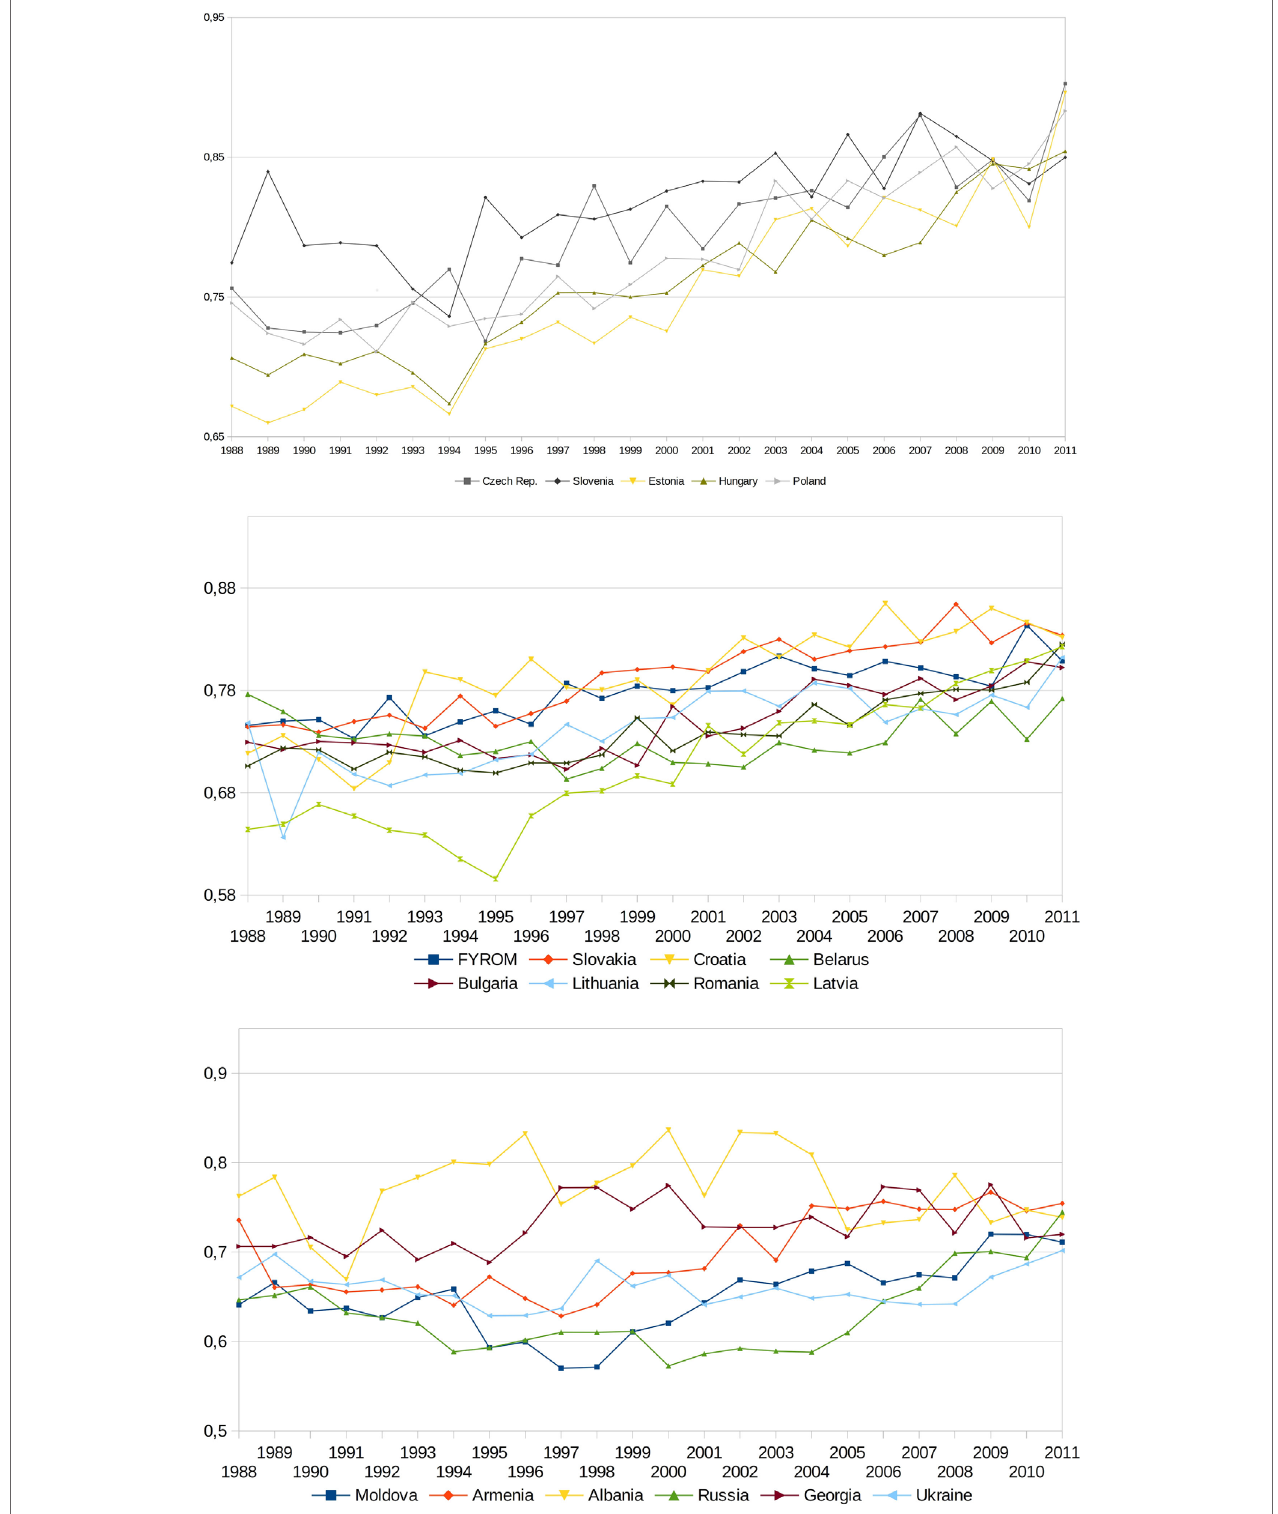
FIGURe 3 | Changes in synthetic outcome measure values for post-communist countries in period